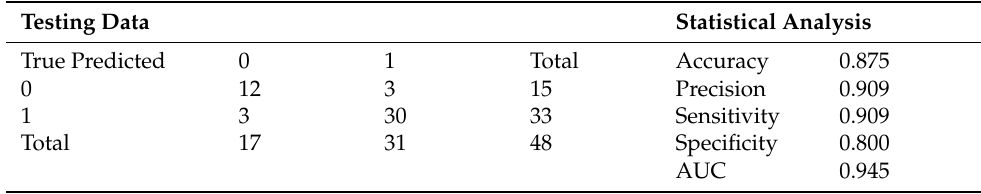
Table 5. Confusion matrix for the “Discharge”